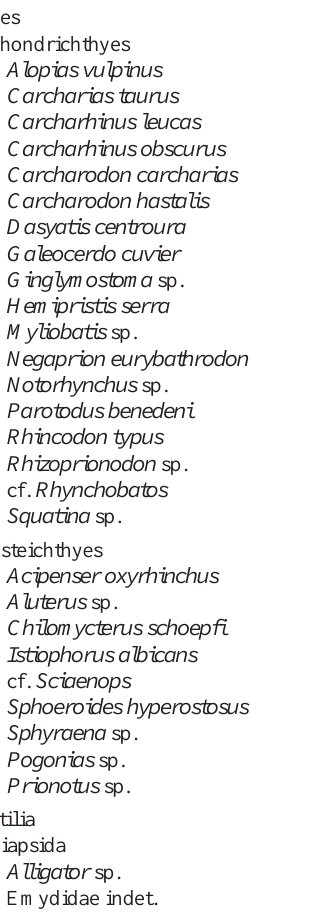
Table 1. List of fossil vertebrates from the Ridgeville Local Fauna, ?Waccamaw Formation, Austin Sand Pit, Ridgeville, South Carolina, USA.